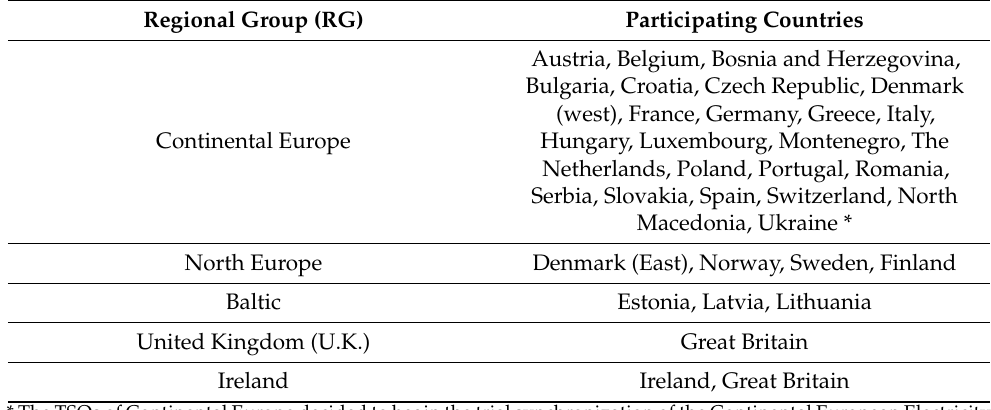
Table 2. Participating countries in the Regional Groups (RG) of ENTSO-E. Regional Group (RG) Participating Countries